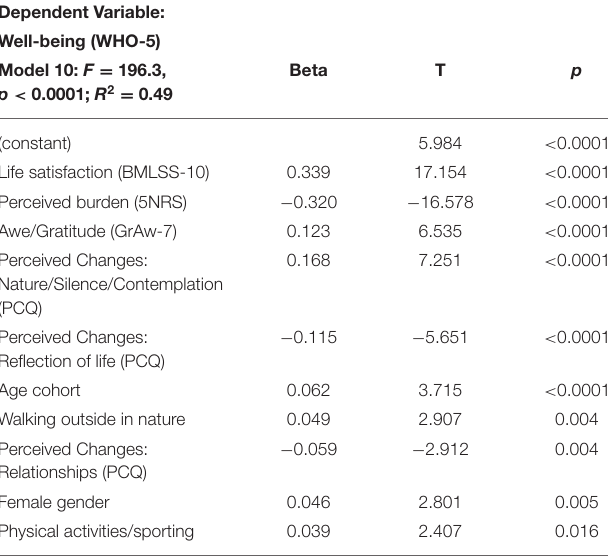
TABLE 6 | Predictors of well-being (stepwise